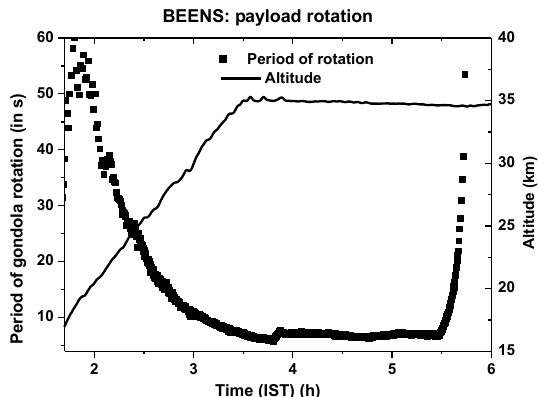
Figure 9. The payload rotation rate (squared symbols) computed using the reference magnetometer data and plotted along with the balloon altitude (continuous